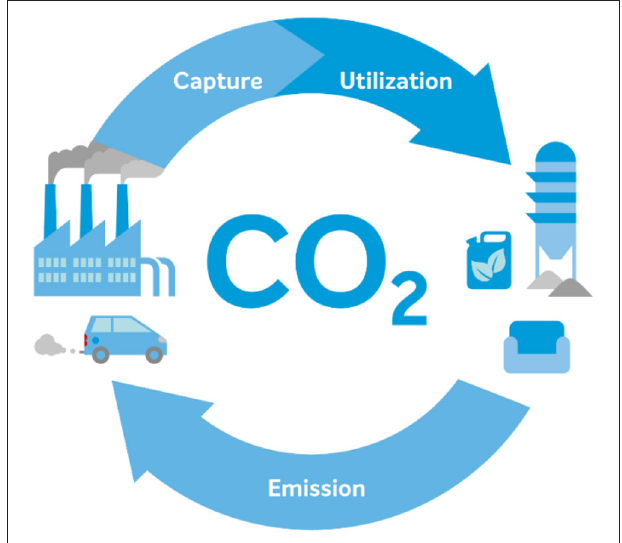
FIGURE 1 | A schematic overview of the carbon capture and utilization (CCU) cycle. Products and services (right) release carbon emissions during their lifecycle. Through CCU, these emissions can be captured and utilized in various conversion processes to provide products and services once again, closing the cycle. Reprinted with permission from Zimmermann et al.